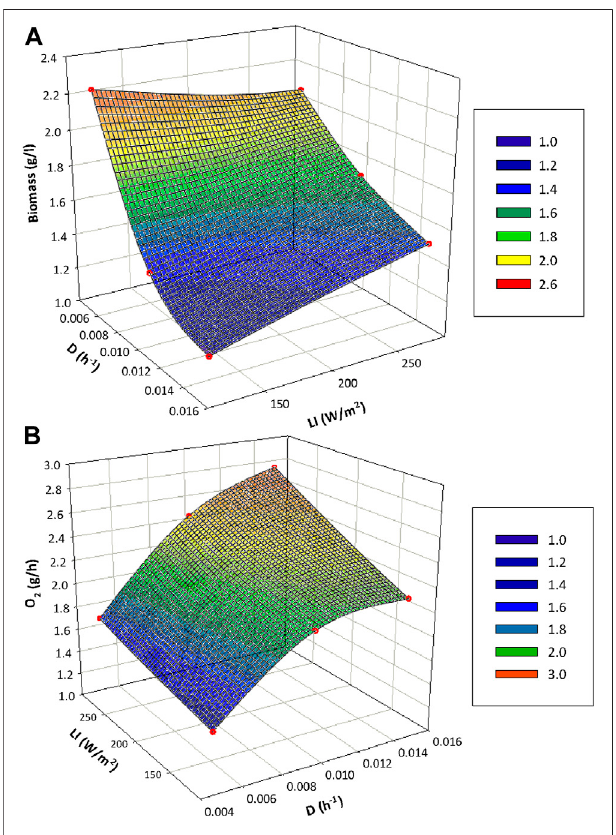
FIGURE 5 | In fl uence of light and liquid fl ow rate in the performance of the PBR in terms of biomass content (A) and oxygen production (B) . The individual point data is interpolated to reach the mesh